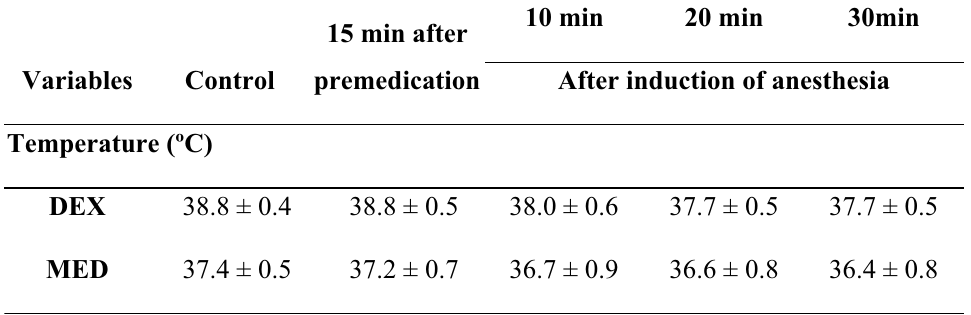
Values as mean ± standard